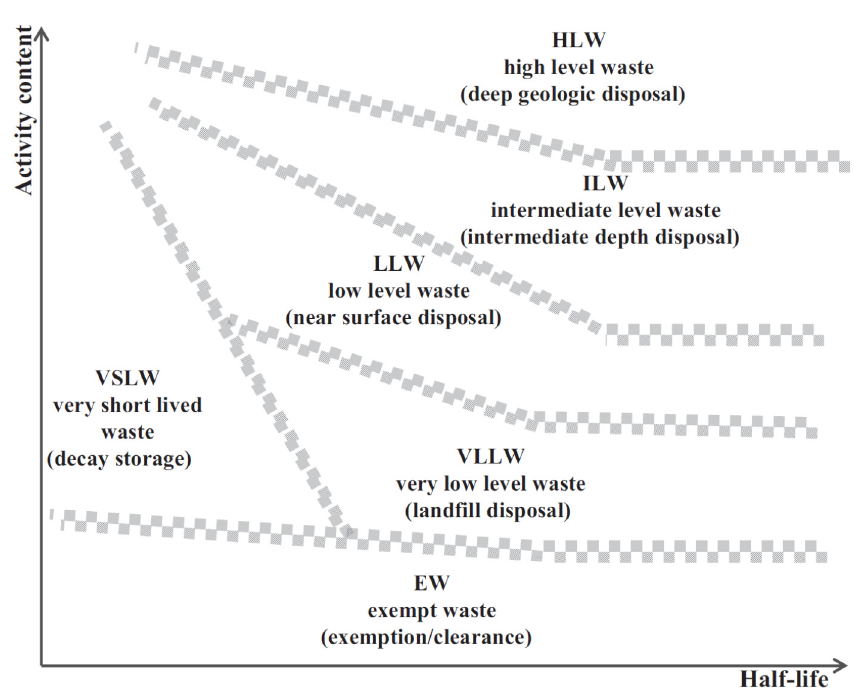
Figure 2. Schematic of IAEA radioactive waste classification scheme. The term “activity content” covers activity concentration and total activity. Reproduced with permission of the IAEA from [16].